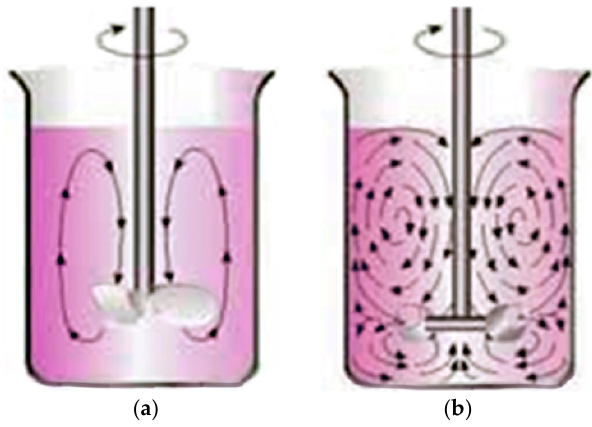
Figure 1. Flows generated by using a helix blade stir bar ( a ) and viscojet stir bar ( b ). The gearbox miller was made and assembled in house as shown in Figure 2.